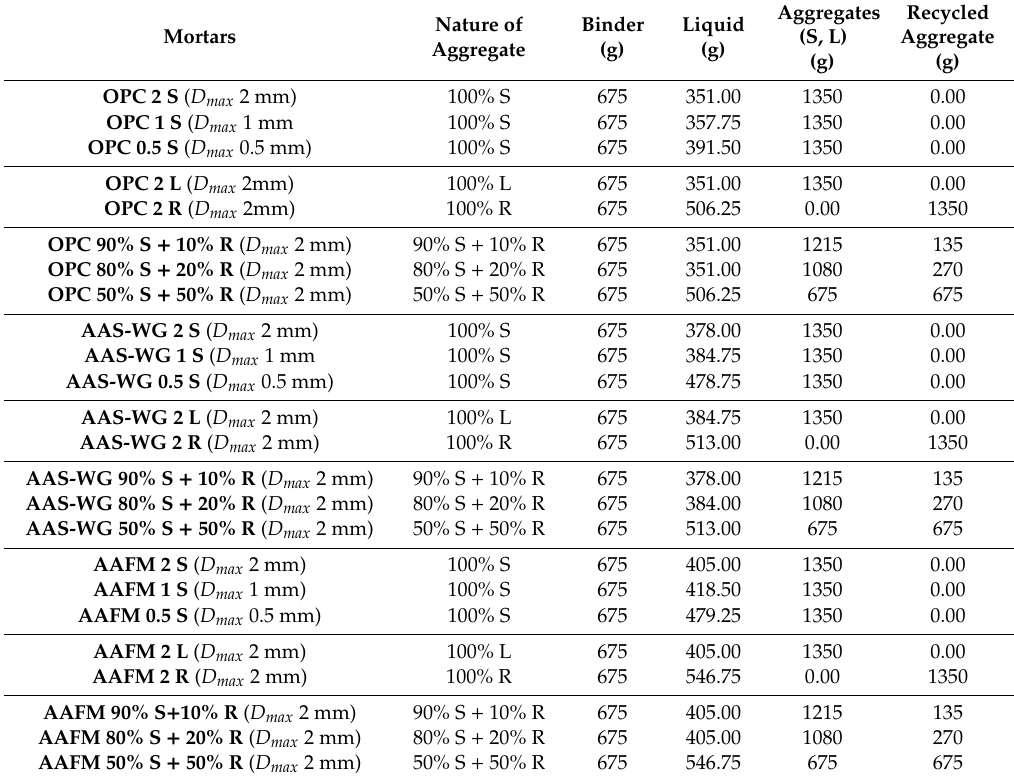
Table 5. Composition of mortars prepared.